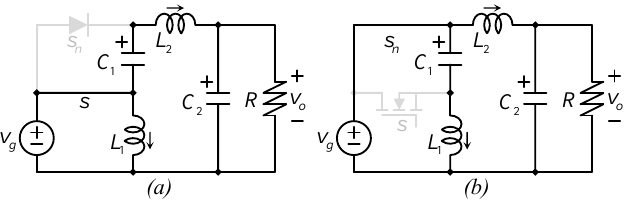
Figure 4. Equivalent circuits of the super-boost converter according to the switching state ( a ) when the switch is closed and ( b ) when the switch is open.